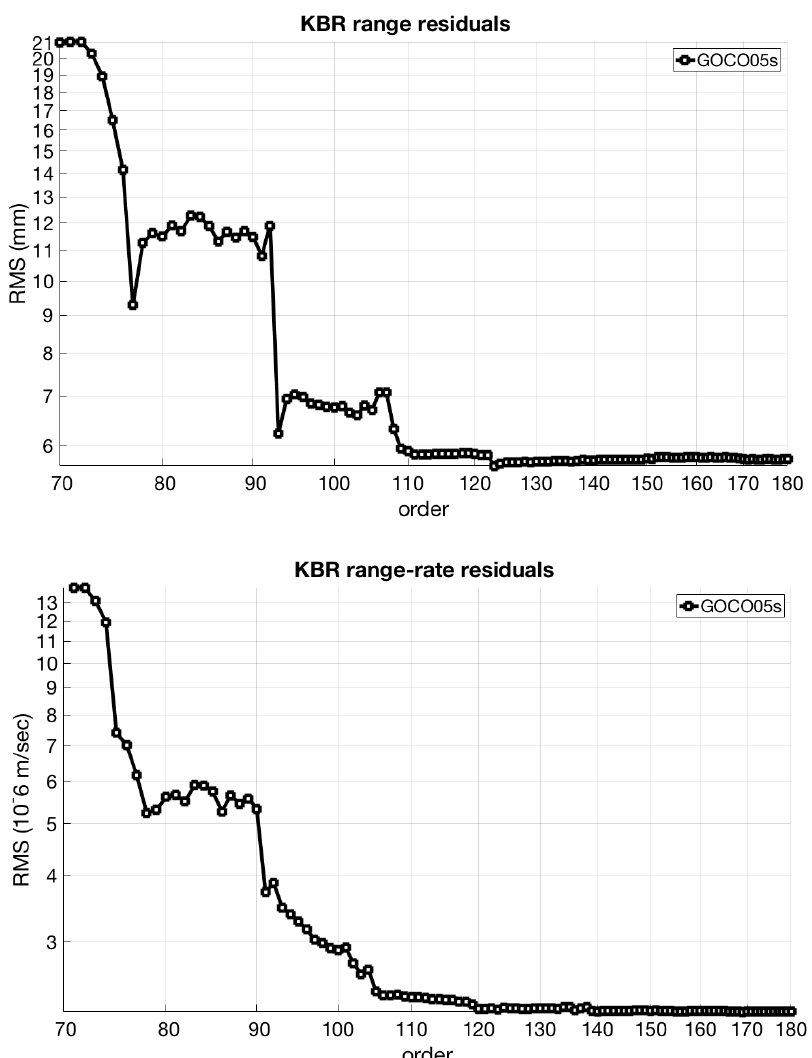
Figure 5. RMS variances of the GRACE inter-satellite ranging data residuals with respect to the order of the spherical harmonic coefficients. Geosciences 2018 , 8 , 441